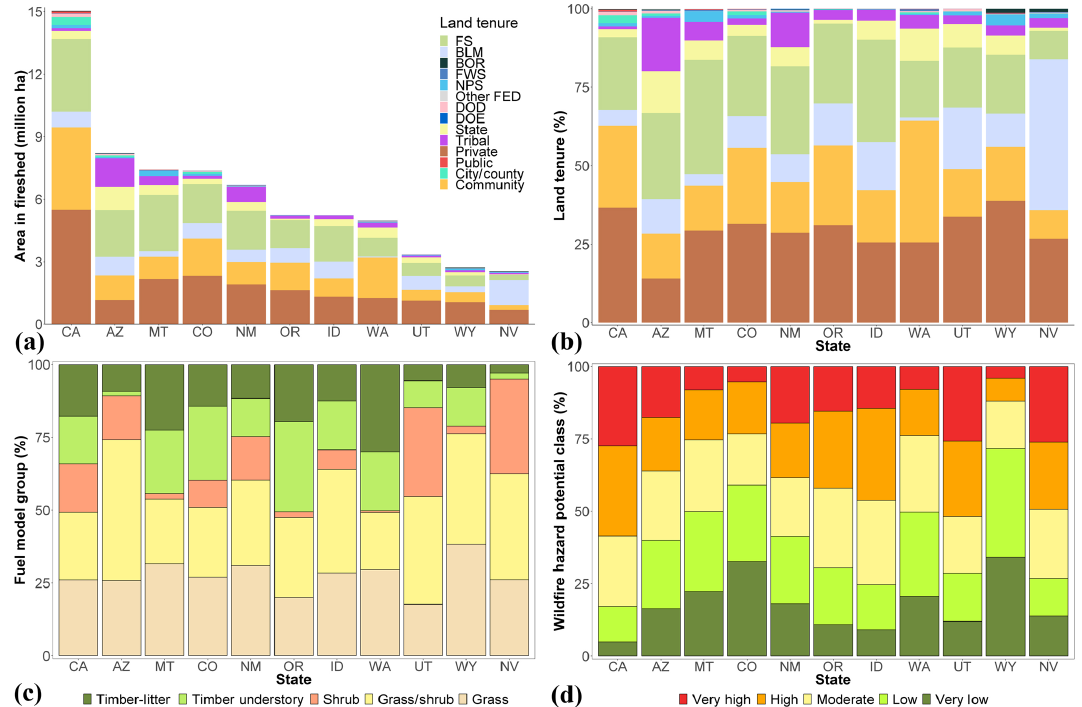
Figure 9. Fireshed characteristics of each western US state in terms of (a) land tenure area; (b) land tenure percentage; (c) fuel model percentage (Scott and Burgan, 2005); (d) average wildfire hazard potential class percentage (Dillon et al., 2015). FS: Forest Service; BLM: Bureau of Land Management; BOR: Bureau of Reclamation; FWS: Fish & Wildlife Service; NPS: National Park Service; DOD: Department of Defense; DOE: Department of